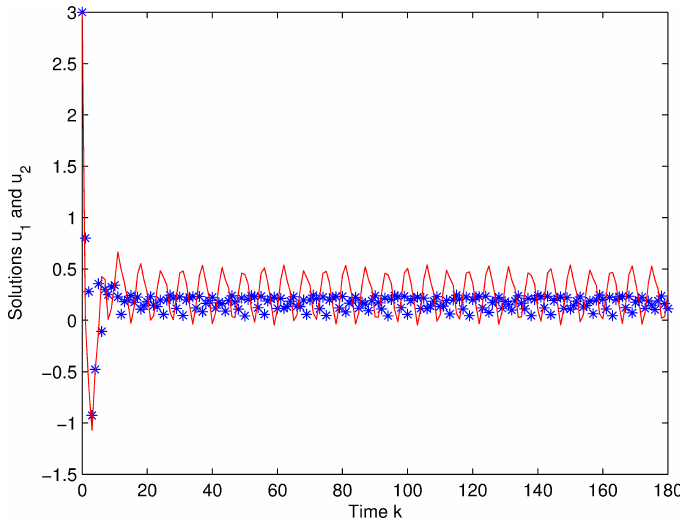
Fig. 2. Times series of u 1 and u 2 for system (73) , where the blue line stands for u 1 and the red line stands for u 2 .